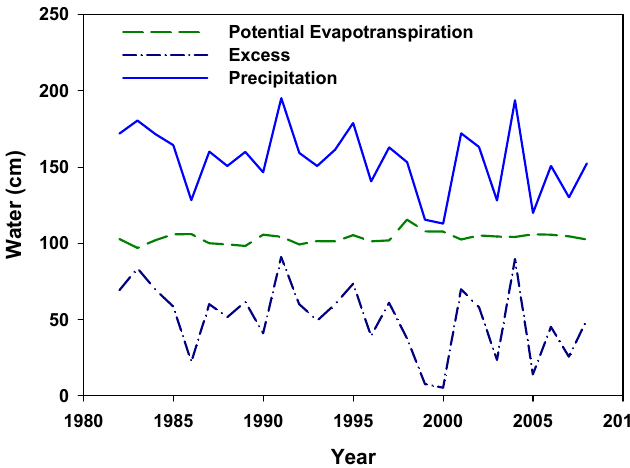
Figure 1. Potential evapotranspiration (PET), precipitation and excess water (PET-precipitation) in central Louisiana, USA from 1982 to